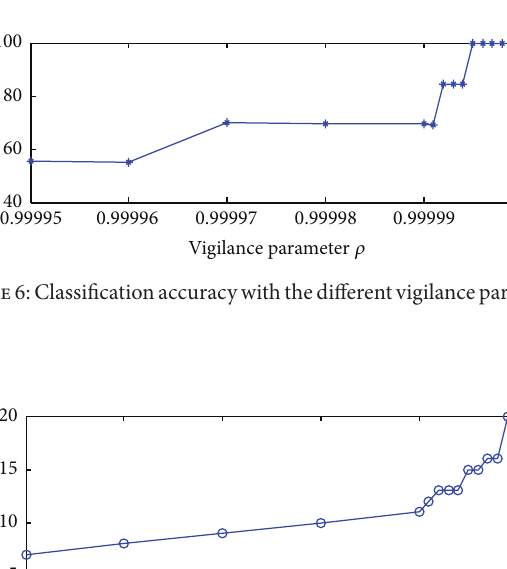
Table 3: Number of neurons presenting each